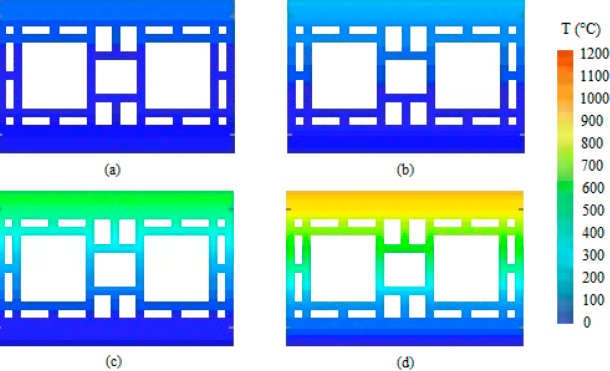
Figure 17. Temperature distribution of the tile at ( a ) 30 min, ( b ) 60 min, ( c ) 120 min and ( d ) 240 min.